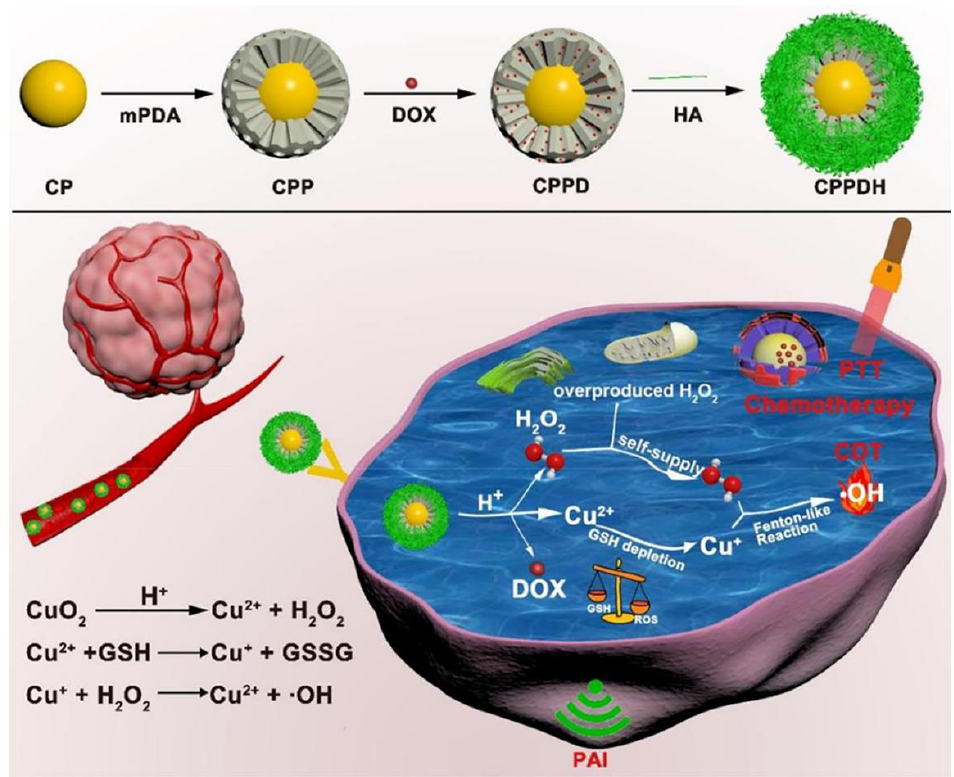
Figure 6. The synergistic auto-enhancing CDT, photothermal therapy, and chemotherapy that CPPDH uses as part of its therapeutic mechanism are shown in a schematic diagram. Reproduced with permission from ref. [35] . Copyright © 2022, American Chemical Society.